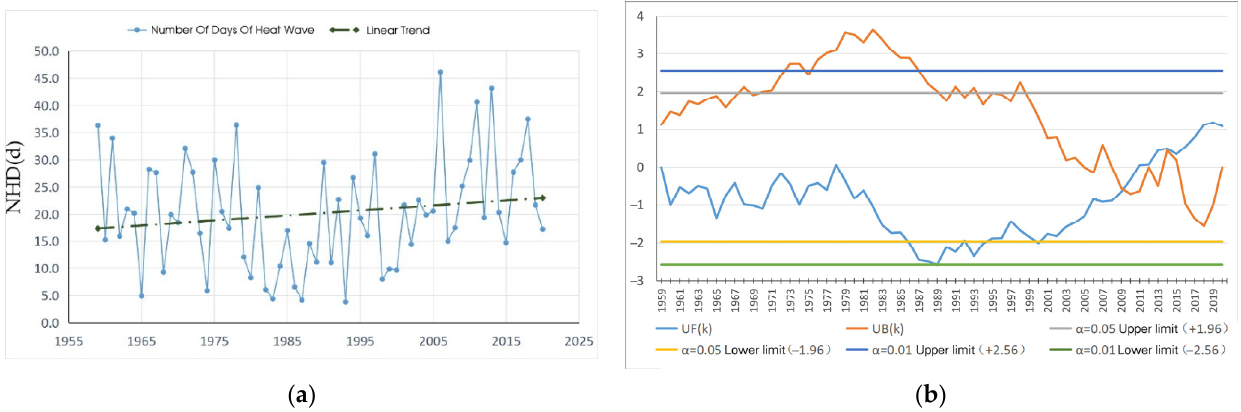
Figure 3. Historical changes in the NHD in Chongqing from 1959 to 2020 and M-K test curves; ( a ) changes in NHD; ( b ) M-K test curves.